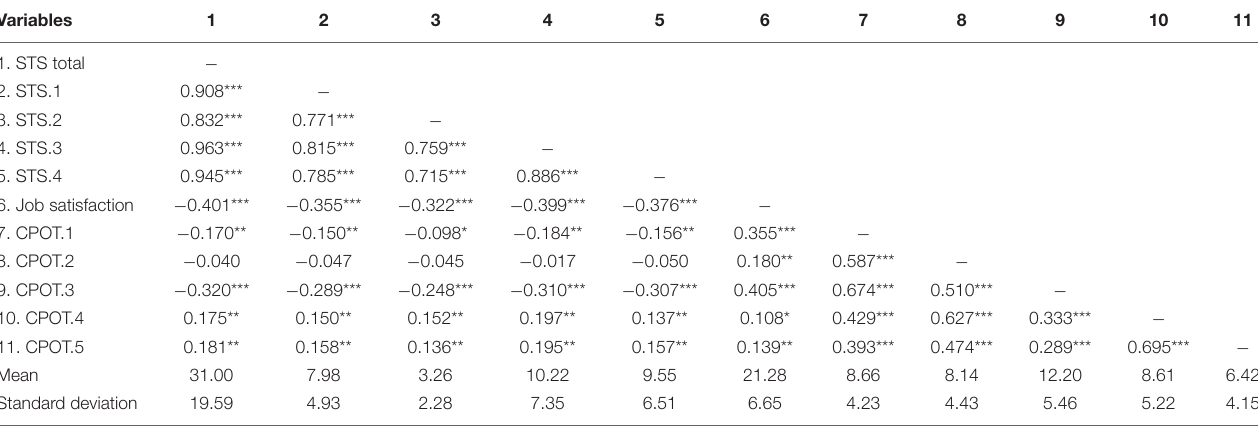
TABLE 1 | Descriptive statistics of analyzed variables ( N = 419).